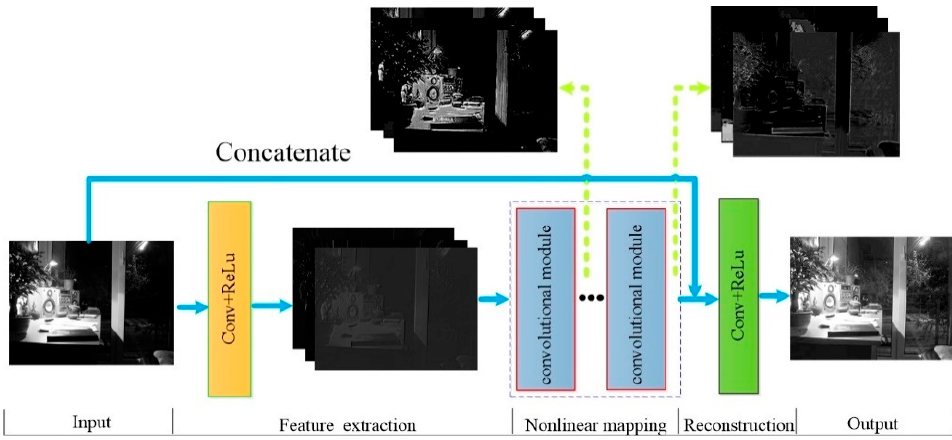
Figure 5. The network structure of DCNN for enhancing intensity.